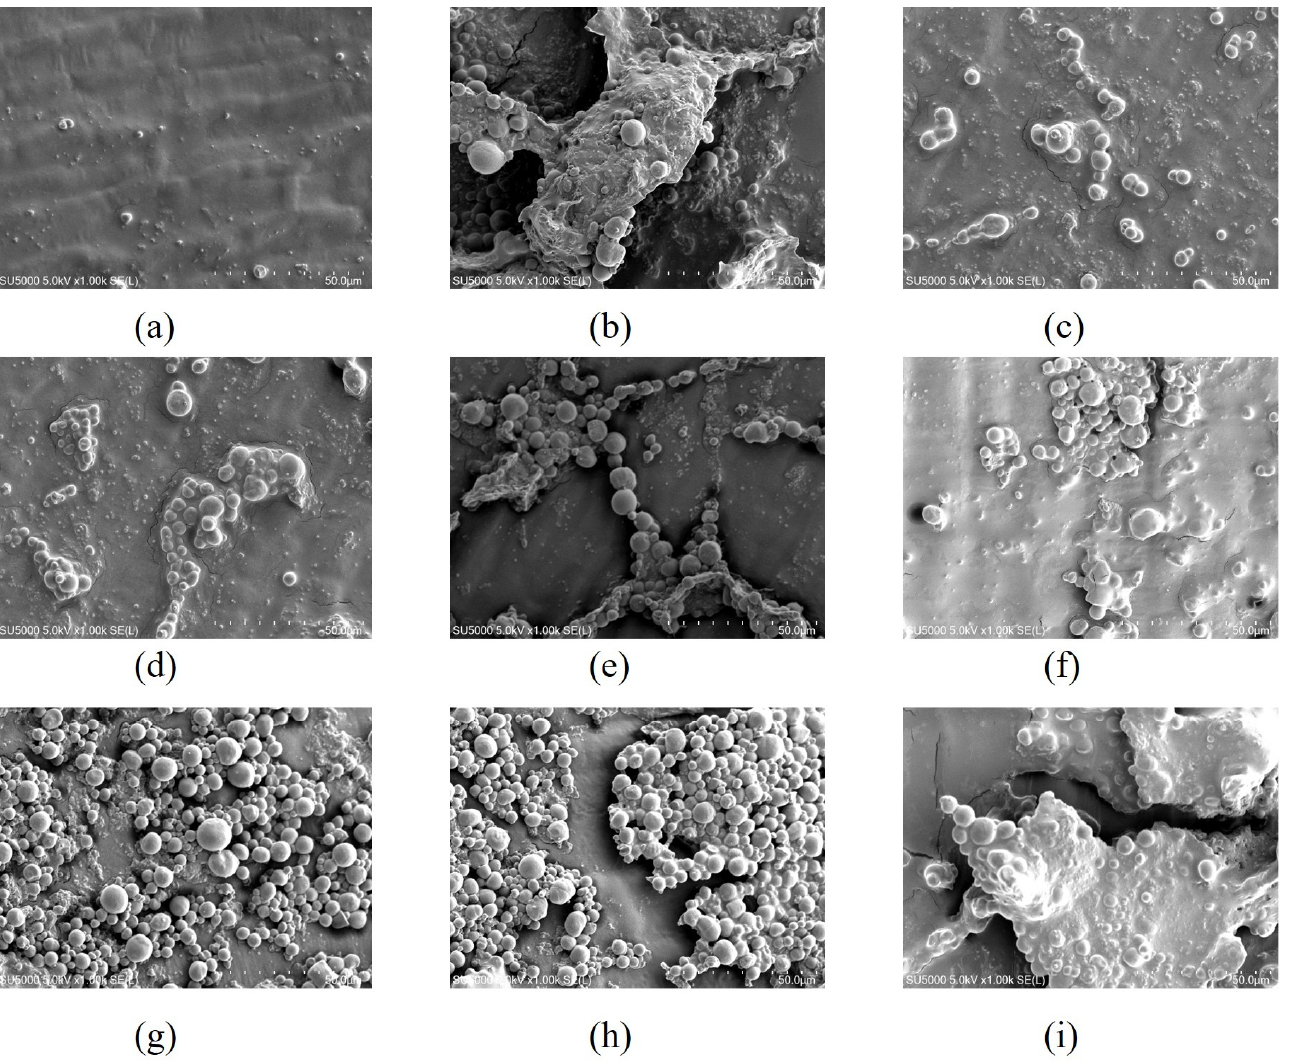
Figure 3. Scanning electron microscopy images of fresh sweet corn in the early storage period ( a ); ultrasound-assisted freezing of sweet corn epidermis in the middle storage period ( b ), brine freezing of sweet corn epidermis in the middle storage period ( c ), strong wind freezing of sweet corn epidermis in the middle storage period ( d ) and refrigerator freezing of sweet corn epidermis in the middle storage period ( e ); ultrasound-assisted freezing of sweet corn epidermis in the post storage period ( f ), brine freezing of sweet corn epidermis in the post storage period ( g ), strong wind freezing of sweet corn epidermis in the post storage period ( h ), and refrigerator freezing of sweet corn epidermis in the post storage period ( i ).